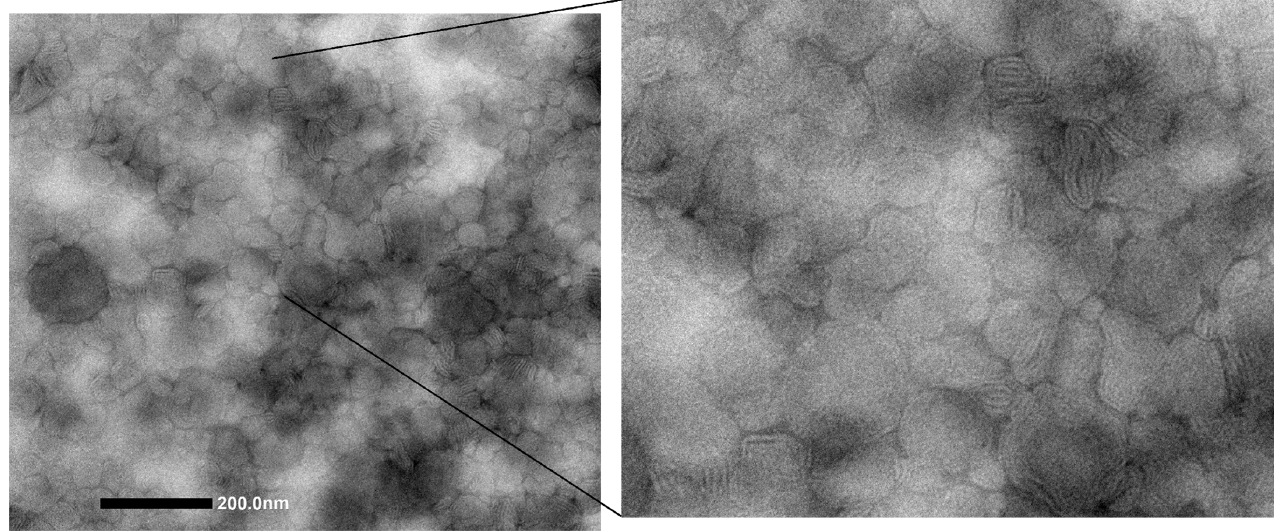
Figure 2. TEM image of ANP0903 PEG-liposomes. The PEG-liposomes were monitored during storage by evaluating the mean diameter, polydispersity, and zeta potential. After 2 months of storage, no signs of significant physical alteration were detected, as demonstrated by the fact that the three parameters changed only slightly (MD 96 nm ± 4.7, PI 0.28 ± 0.02, ZP − 16 mV ± 6.4). In addition, the stability of the PEG-liposomes was evaluated in a simulated biological fluid. Hanks’ solu- tion is commonly used to simulate body fluids, as it contains inorganic salts and glucose that confer a similar osmotic pressure as that of intercellular fluids [15]. PEG-liposomes remained essentially unaltered after dilution and incubation for 24 h with Hank’s solu- tion. The mean diameter and PI did not change significantly from the initial values, being around 80 nm and 0.20, respectively (Table 2). This indicates that their structure was pre- served despite osmotic stress caused by the high ions’ concentration in the medium. On the other hand, the zeta potential values varied, approaching neutrality (Table 2), due to the ions adsorbed on the vesicles’ surface. Table 2. Mean diameter (MD), polydispersity index (PI), and zeta potential (ZP) of PEG-liposomes diluted and incubated with a simulated body fluid (Hank’s solution, pH 7.4) for 24 h, at 37 °C. The measurements were carried out immediately after the dilution (t 0 ) and after 24 h (t 24 ) of incubation. Mean values ± SD are reported ( n = 6). Formulation